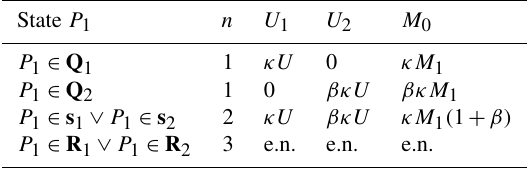
Table 1. Final slip amplitudes U 1 and U 2 of asperity 1 and 2 and seismic moment M 0 during a seismic event made up of n slipping modes, as a function of the state P 1 where the event started. The entry e.n. is the abbreviation for evaluated numerically.